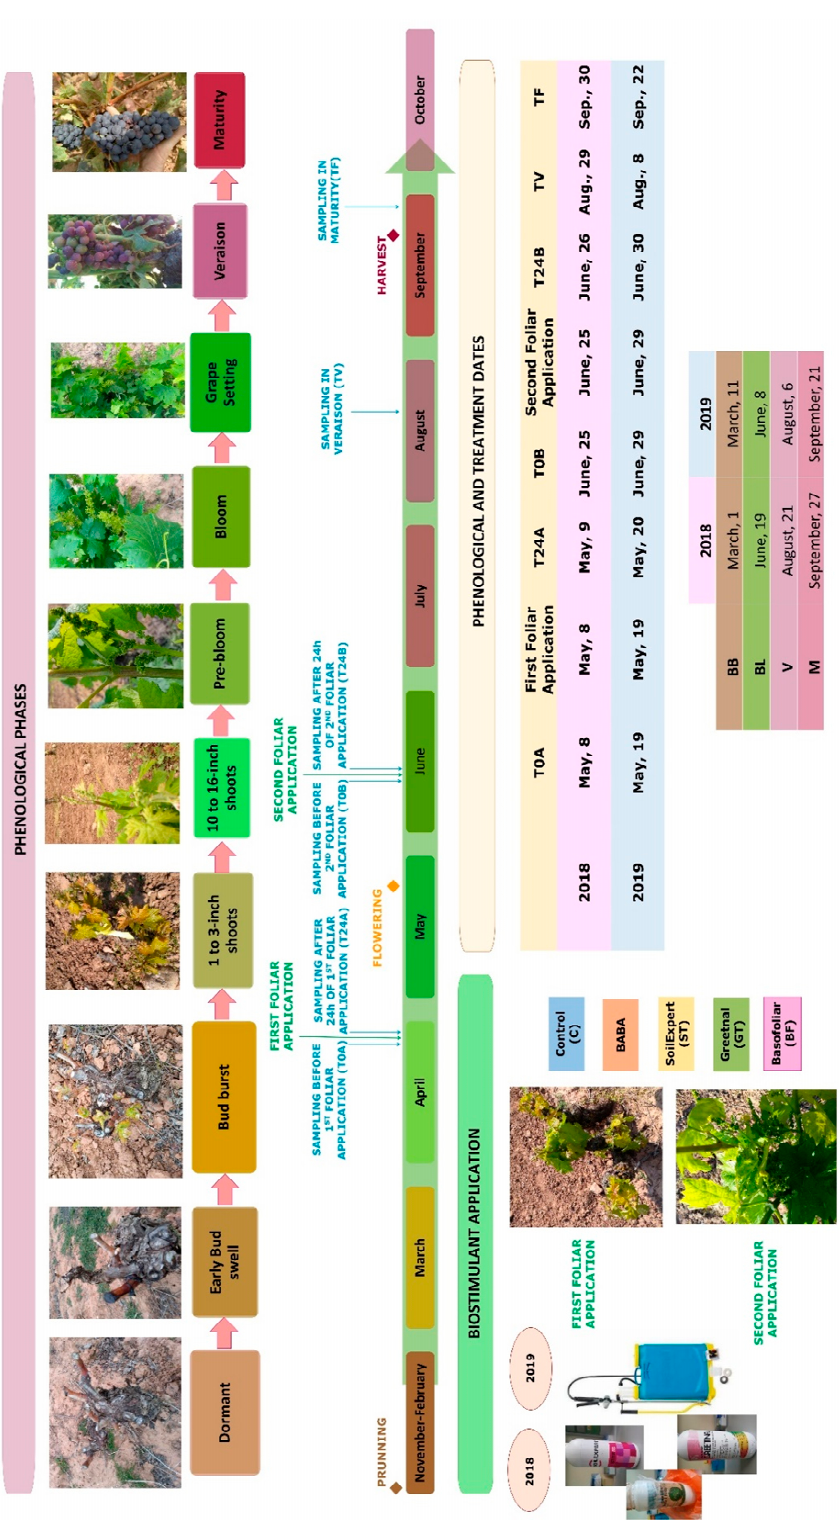
Scheme 1. Experimental setup in Vitis vinifera var.